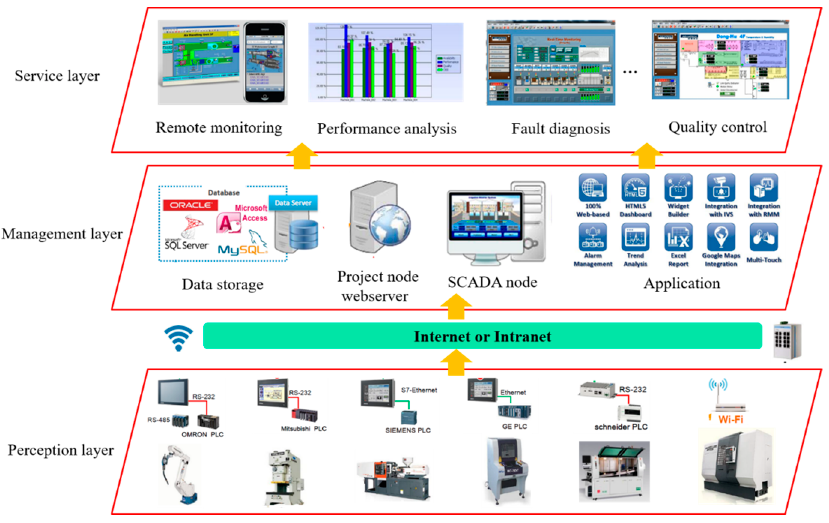
Figure 1. The service-oriented layered architecture of industrial IoT.